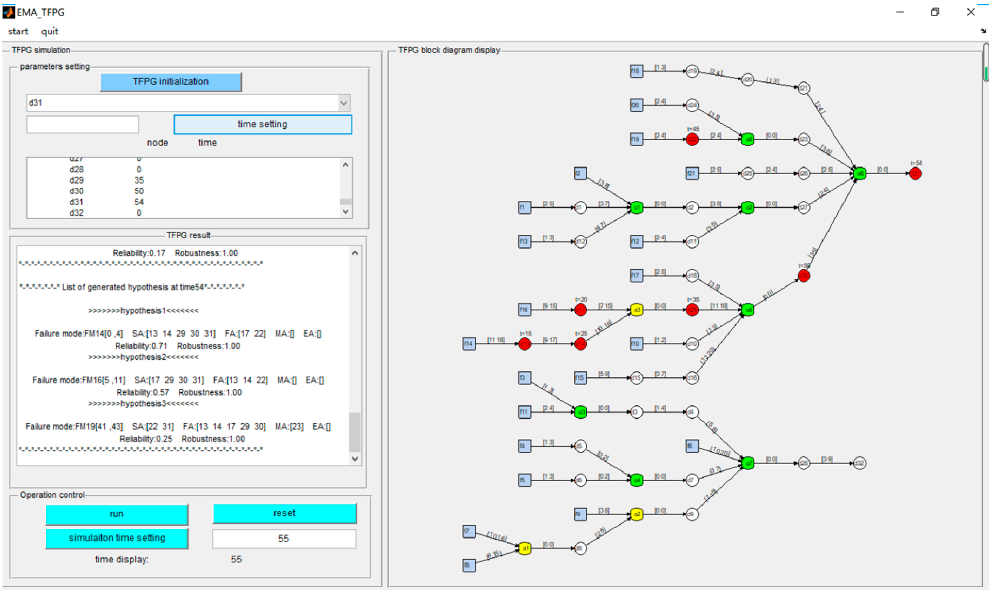
Figure 8. The systematic verification scheme.